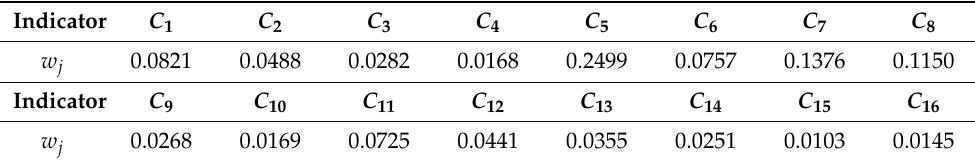
Table 2. The weight of the water resource scarcity evaluation